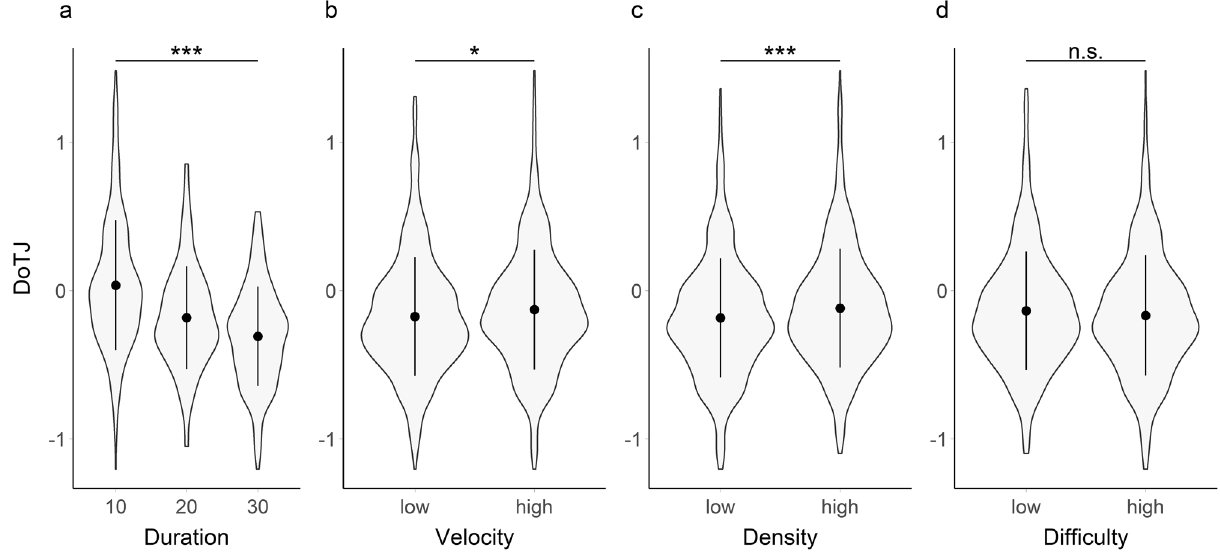
Figure 2. Violin plots of proportional deviation estimates (log(estimated duration/duration)) of DoTJs for the three different stimulus durations (10, 20, and 30 s; a ), and two different level of velocity ( b ), density ( c ), and difficulty ( d ) in Exp. 1. Proportional duration estimates > 0 can be interpreted as overestimations of interval durations while values < 0 mean an underestimation of interval durations. Central dots indicate the means over all subjects, central vertical lines indicate the sd. Asterisks indicate significant differences between factor levels (* < 0.05; ** < 0.01, *** < 0.001, n.s.: not